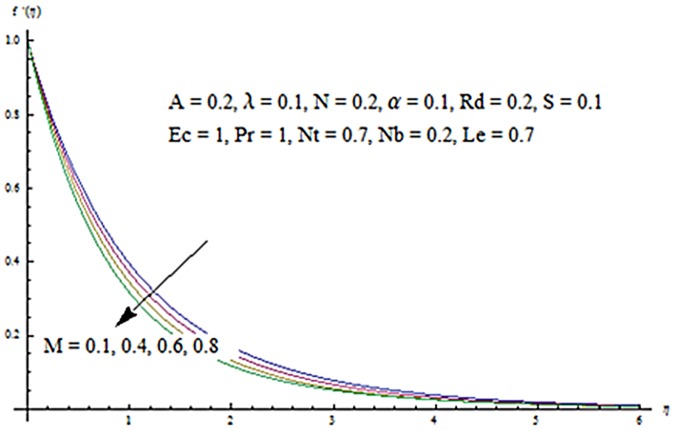
Influence of M on f′.